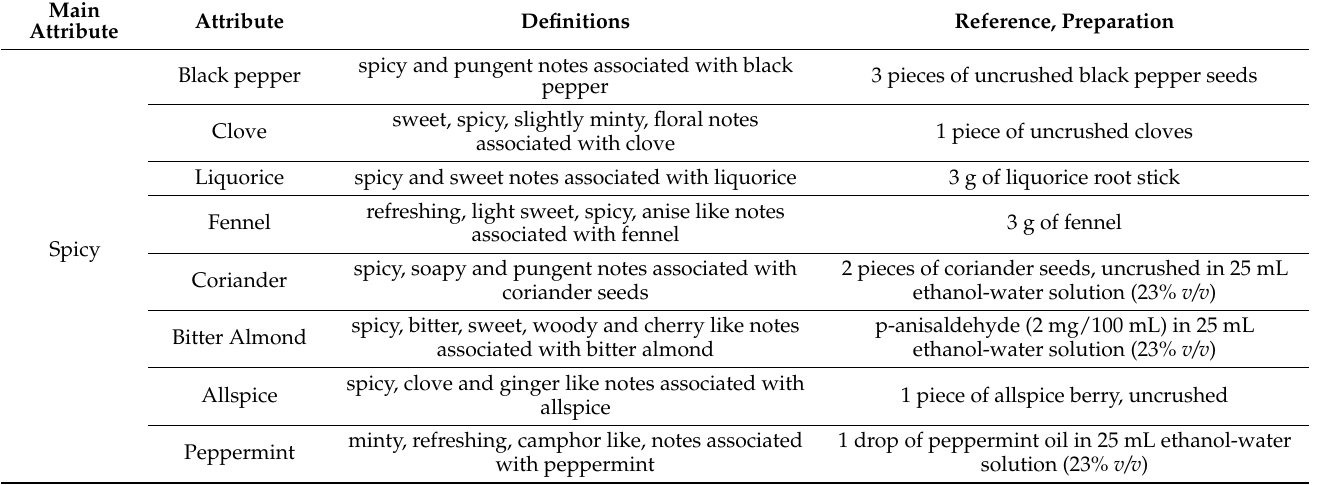
Table 4. Attributes and references for the Rakı